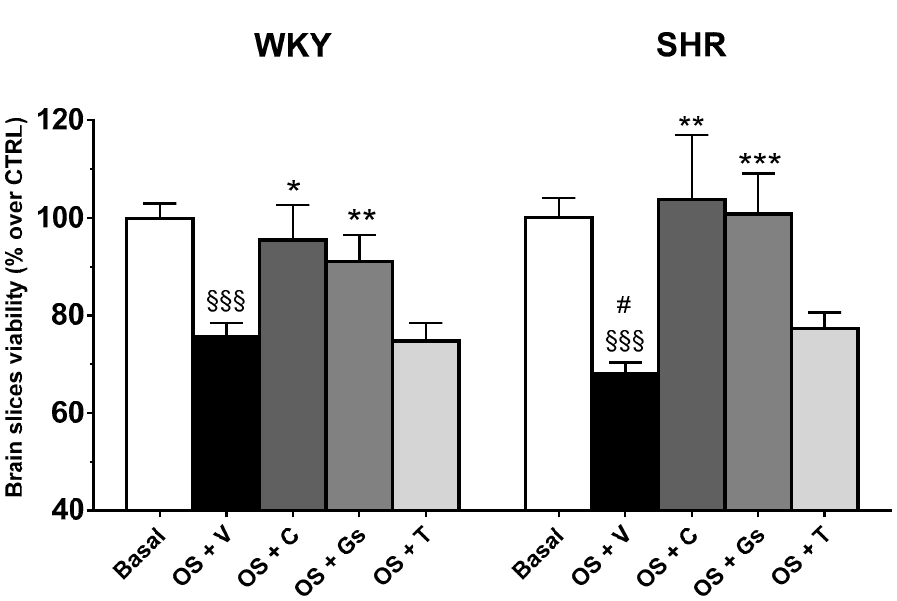
Figure 4. SHRs and WKY rats were treated for four weeks with tomato aqueous fraction (Gs, 400